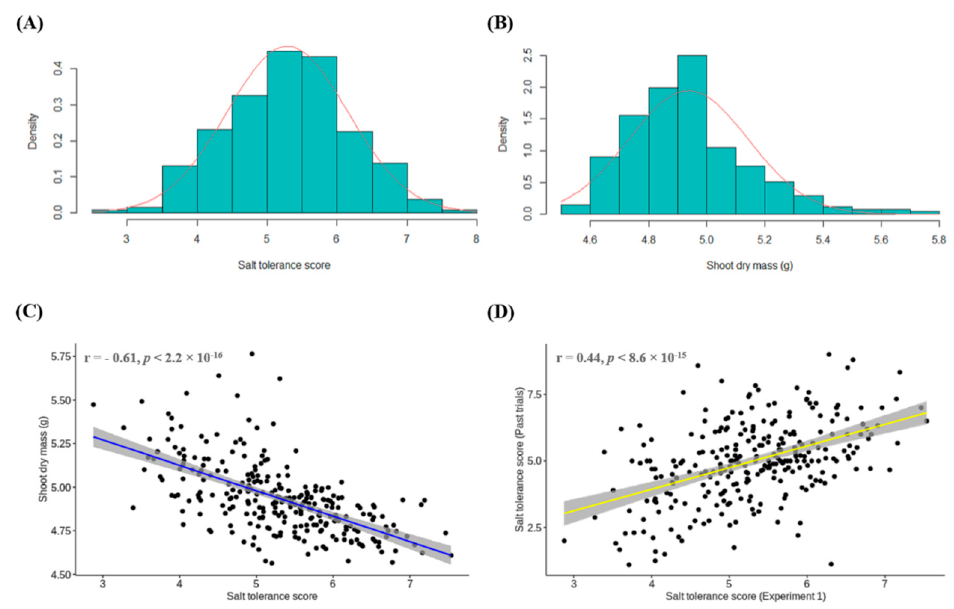
Figure 3. Distribution graphs of salt tolerance traits using a conventional phenotyping method (Experiment 1): ( A ) salt tolerance score, where 1 is tolerant and 10 is intolerant, ( B ) shoot dry mass (g), ( C ) correlation plot between salt tolerance score and shoot dry mass, and ( D ) Spearman rank correlation plot for the scores obtained from the current study (Experiment 1) and scores captured from historical breeding program trials .